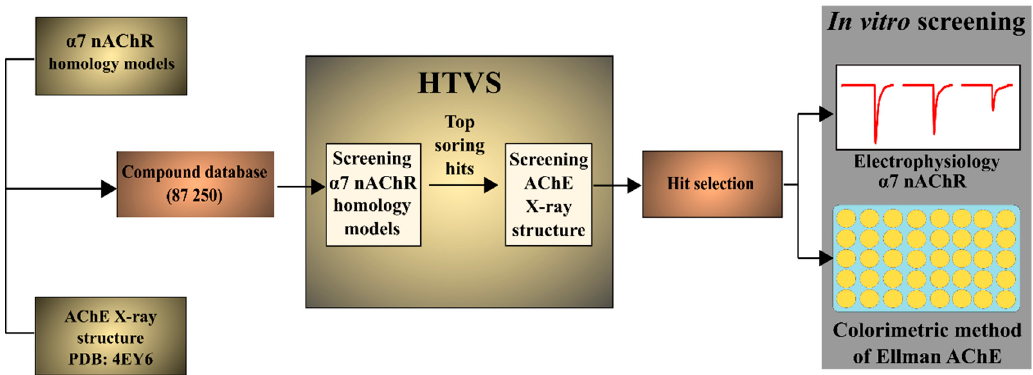
Figure 7. Screening workflow. Virtual screening was performed at two α 7 nAChR homology models having different volumes of the binding pocket. Top scoring hits from both models were subsequently screened at the X-ray structure of AChE (PDB ID: 4EY6). From hits scoring high at both targets, 13 compounds were selected and tested in vitro. HTVS = high throughput virtual